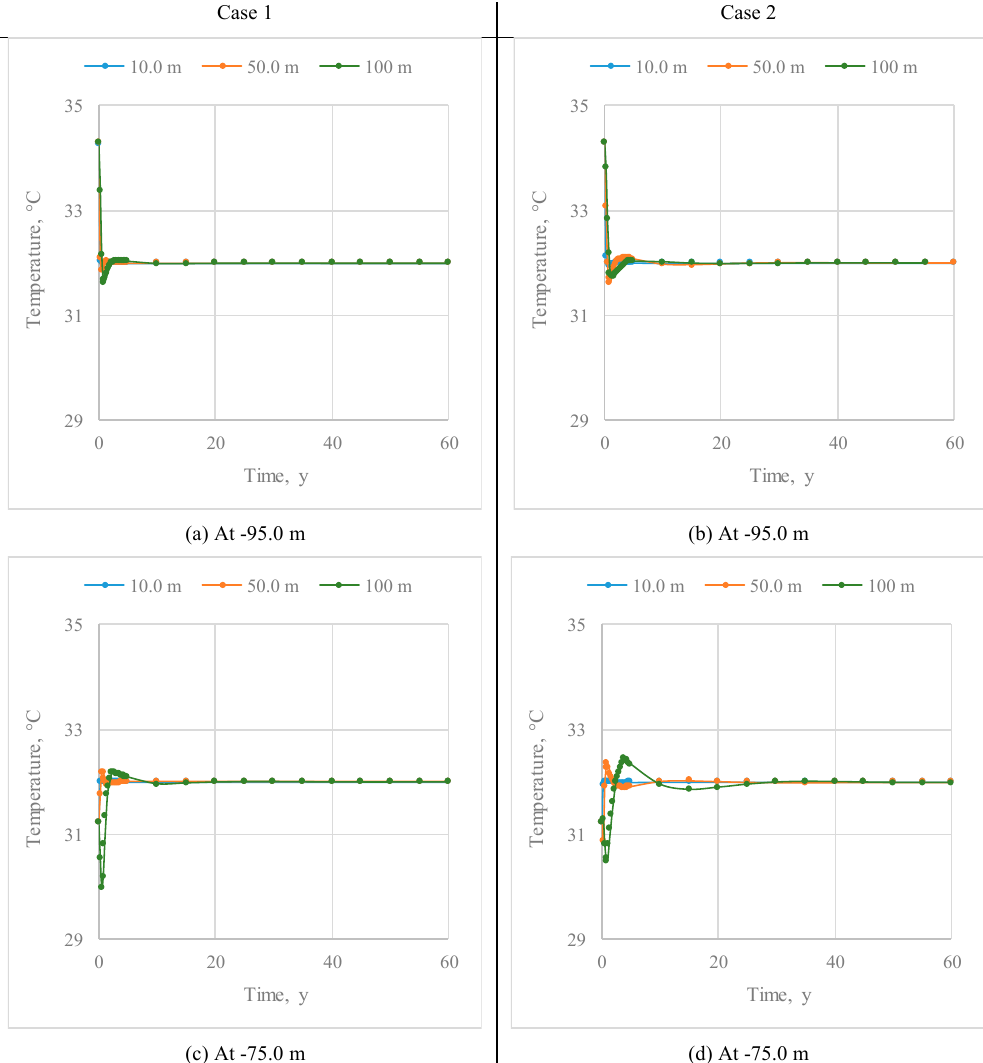
Figure 15. Temperature over time at three different distances from the wells (10.0, 50.0, and 100 m), for two different depths ( − 95.0 and − 75.0m).